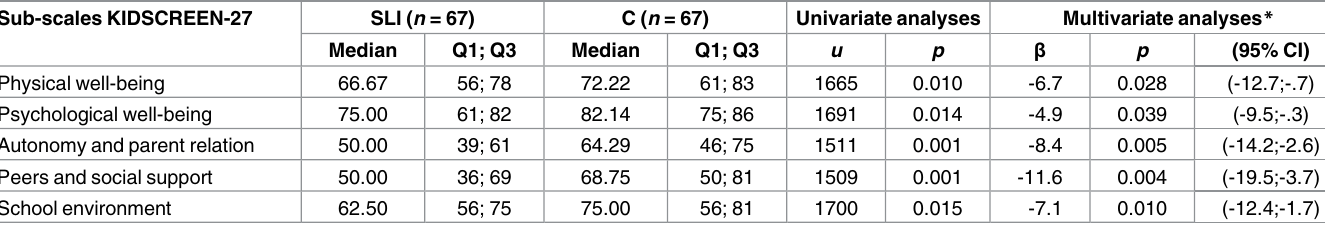
Table 4. Comparison of the KIDSCREEN scores of the specific language-impairment (SLI) and control (C) groups. Sub-scales KIDSCREEN-27 Physical well-being